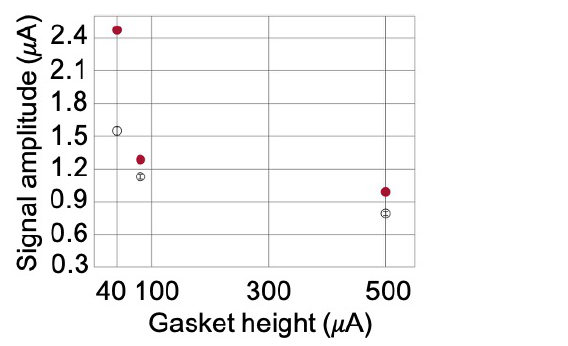
Figure 4. Measured current signal at different heights of the microfluidic chamber containing the blood sample (black dots) and the relative COMSOL simulation points (empty red dots). The error bars are obtained as the square root of the sum of the squares of the errors on the signal value in the 10 s before the first disengagement of the magnets and the during the 10 s before the second approach of the